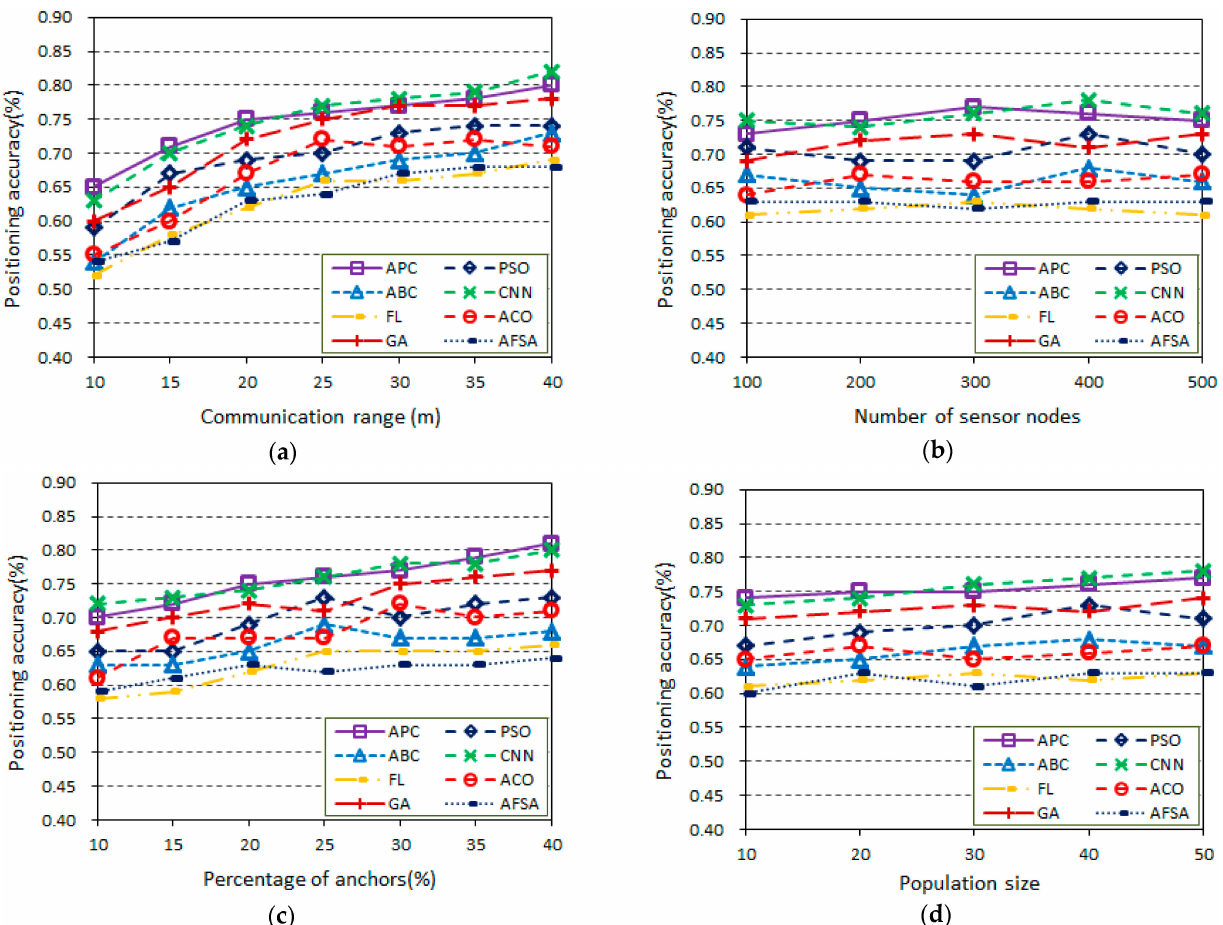
Figure 4. Algorithm comparison in terms of positioning accuracy. ( a ) Communication range vs. positioning accuracy (200 sensor nodes, 20% anchor nodes, population size m = 20); ( b ) the total number of sensor nodes vs. positioning accuracy (communication range r = 20 m, 20% anchor nodes, population size m = 20); ( c ) percentage of anchor nodes vs. positioning accuracy (communication range r = 20 m, 200 sensor nodes, population size m = 20); ( d ) population size vs. positioning accuracy (communication range r = 20 m, 200 sensor nodes, 20% anchor